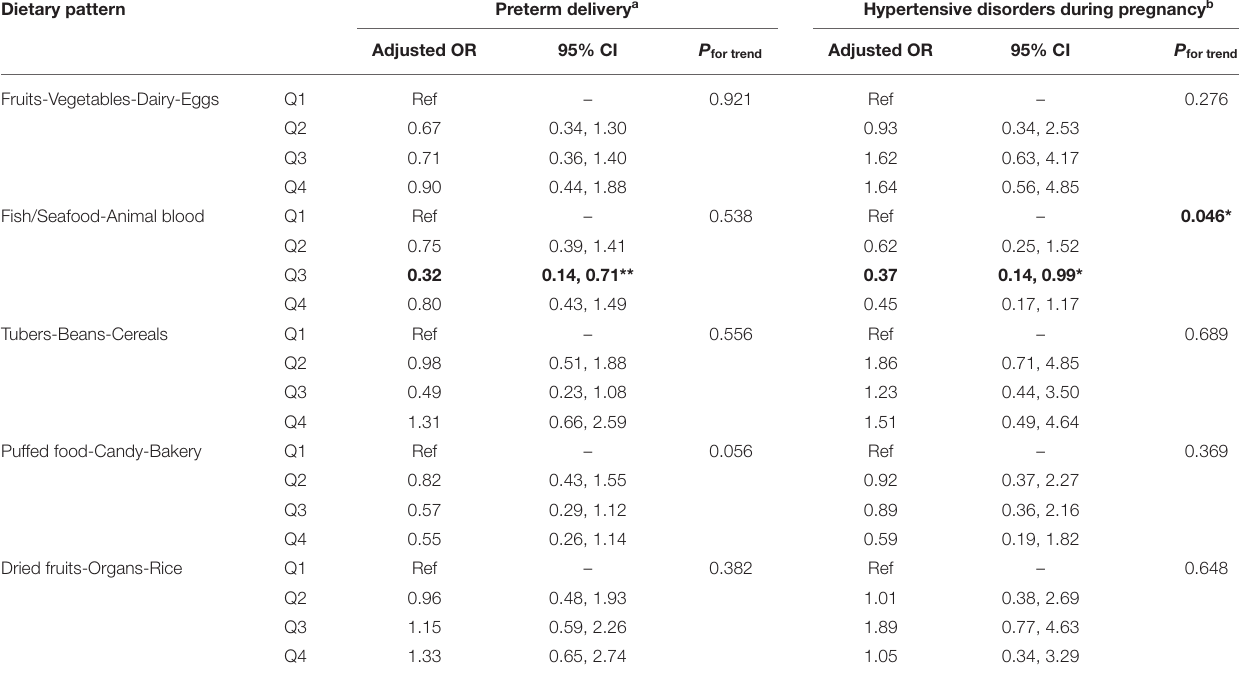
TABLE 6 | Associations of the dietary patterns derived by principal component analysis with preterm delivery and hypertensive disorders during pregnancy ( N = 1,480). Dietary